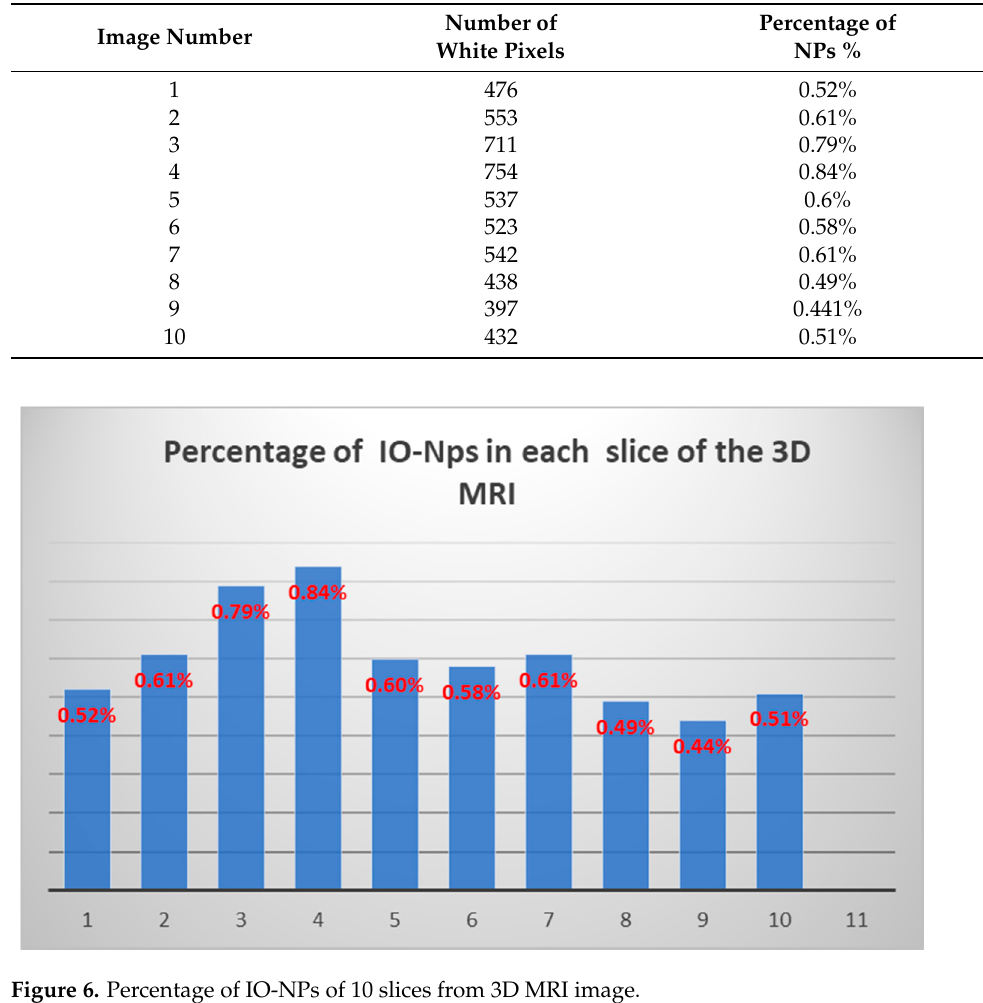
Figure 6. Percentage of IO-NPs of 10 slices from 3D MRI image.